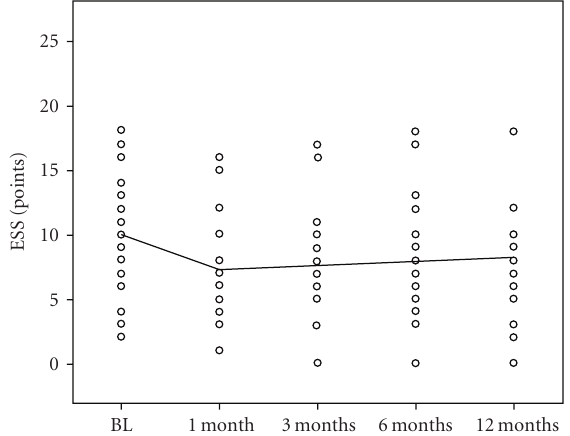
Figure 3: Daytime Sleepiness. BL: Baseline. ESS: Epworth Sleepi- ness Scale. Mo: months.